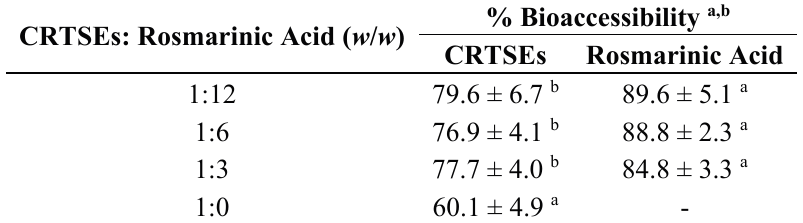
Table 1. The % bioaccessibility of crocetin sugar esters (CRTSEs) and rosmarinic acid (RA) in model mixtures upon simulated gastrointestinal